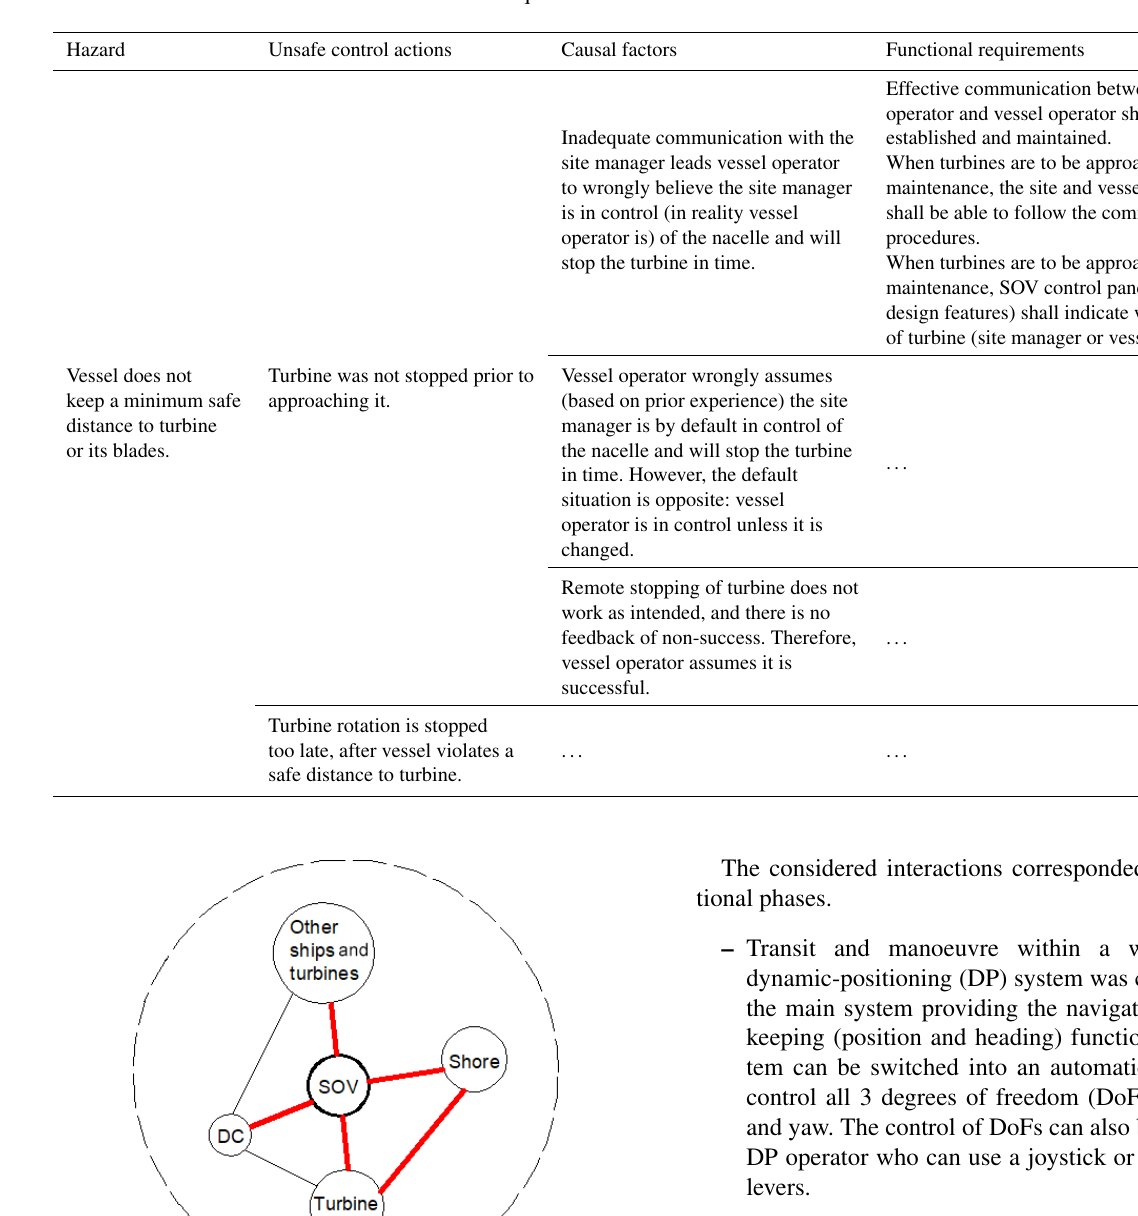
Table 2. Hazardous scenario with three functional requirements.